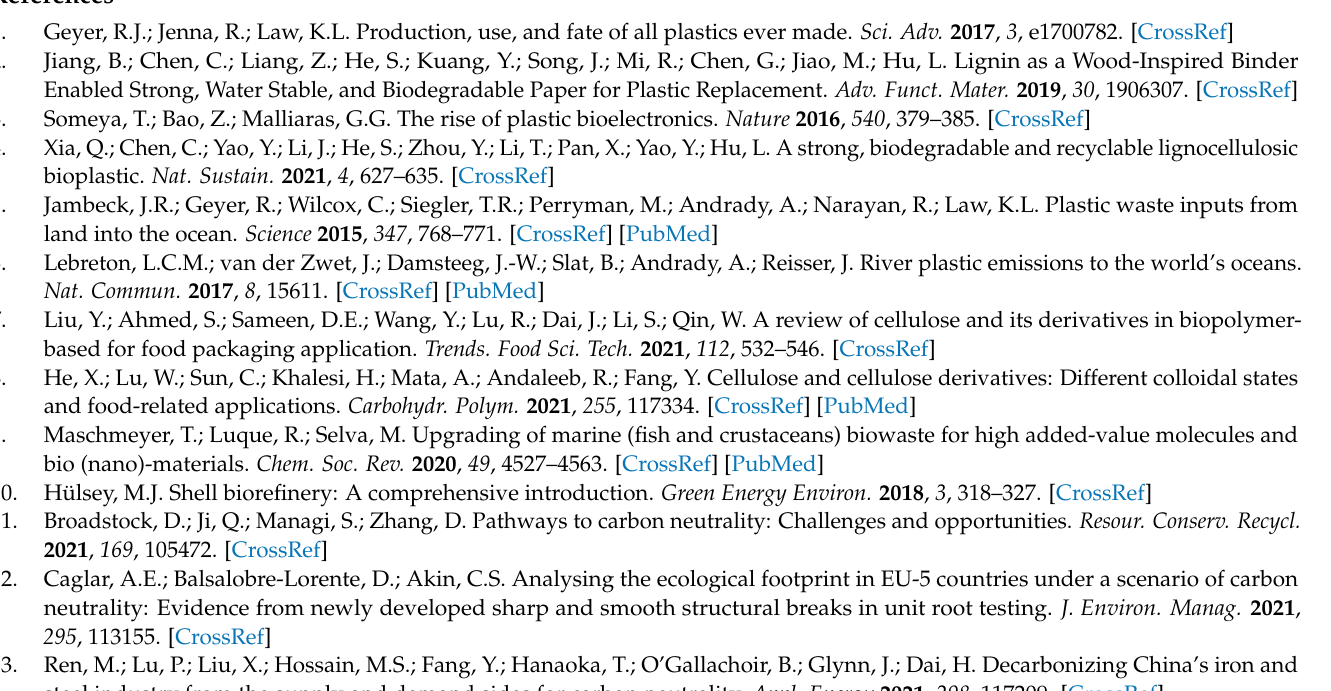
Table S1: The surface roughness of C-film, Film-W and